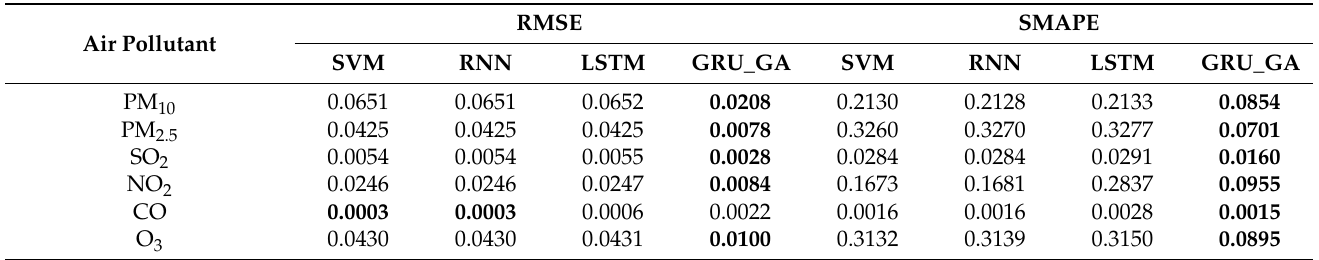
Table 15. The prediction results of GRU_GA compared with other air-quality-prediction methods with Dataset